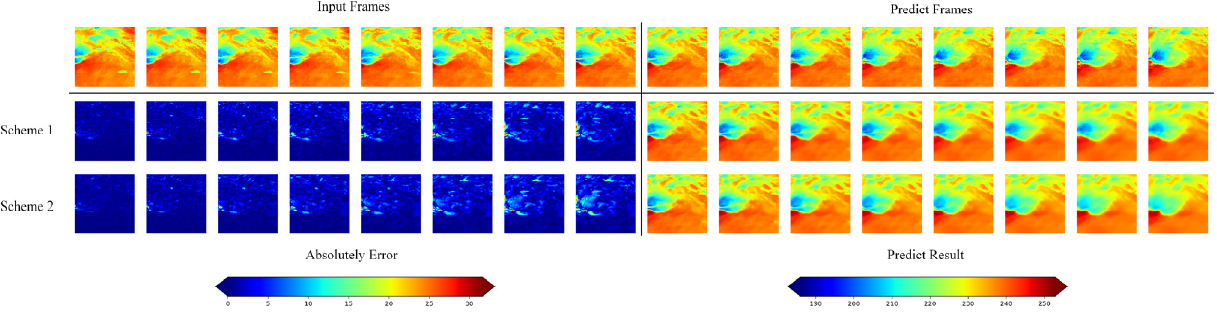
Figure 7. The time series comparison images of the prediction results of the two prediction schemes (Example time 4 May 2020).